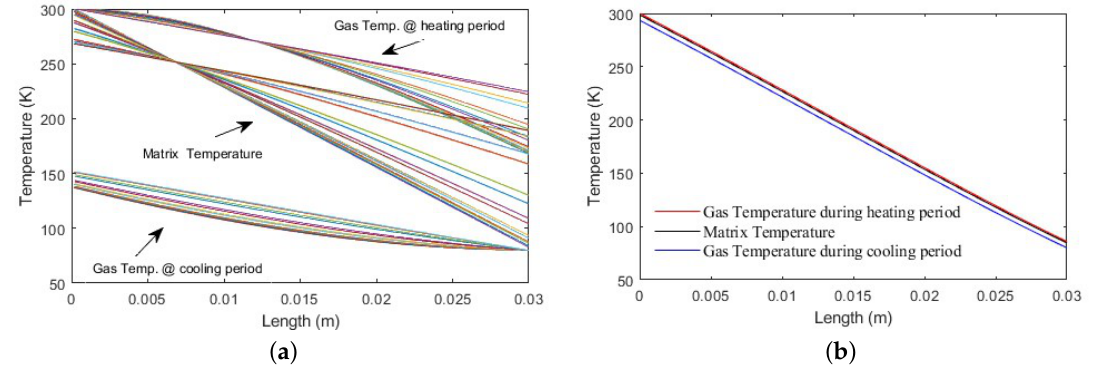
Figure 6. ( a ) Matrix and gas temperature variations during the heating and cooling period. ( b ) The final temperature profiles as they converge to a solution with increasing N x and N t